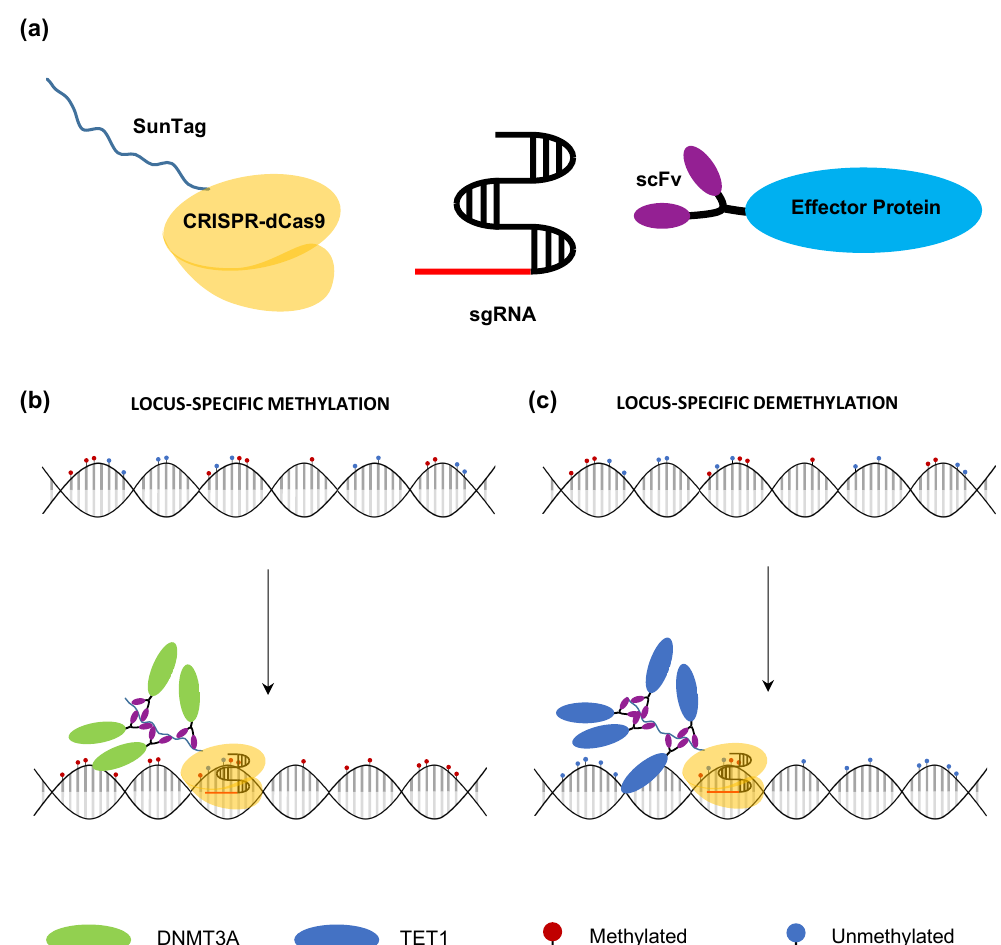
Figure 4. Components of the CRISPR-deactivated Cas9 (dCas9)-based methylation-editing system. ( a ) Depicted are three basic components required for selective methylation or demethylation of a target locus: The CRISPR-dCas9 protein (yellow, top left); a unique gRNA sequence (red) fused to the single-guide RNA (sgRNA) plasmid construct; and the e ff ector protein domain (DNMT3A for methylation or TET for demethylation). ( b ) Locus-specific methylation strategy. The major di ff erence for methylation and demethylation for specific locus editing is the epie ff ector used in the system. For methylation, the epie ff ector DNMT3A (green) catalyzes the addition of methyl marks. ( c ) Locus-specific demethylation strategy. TET1 enzyme (blue) is used as an epie ff ector for the removal of methyl